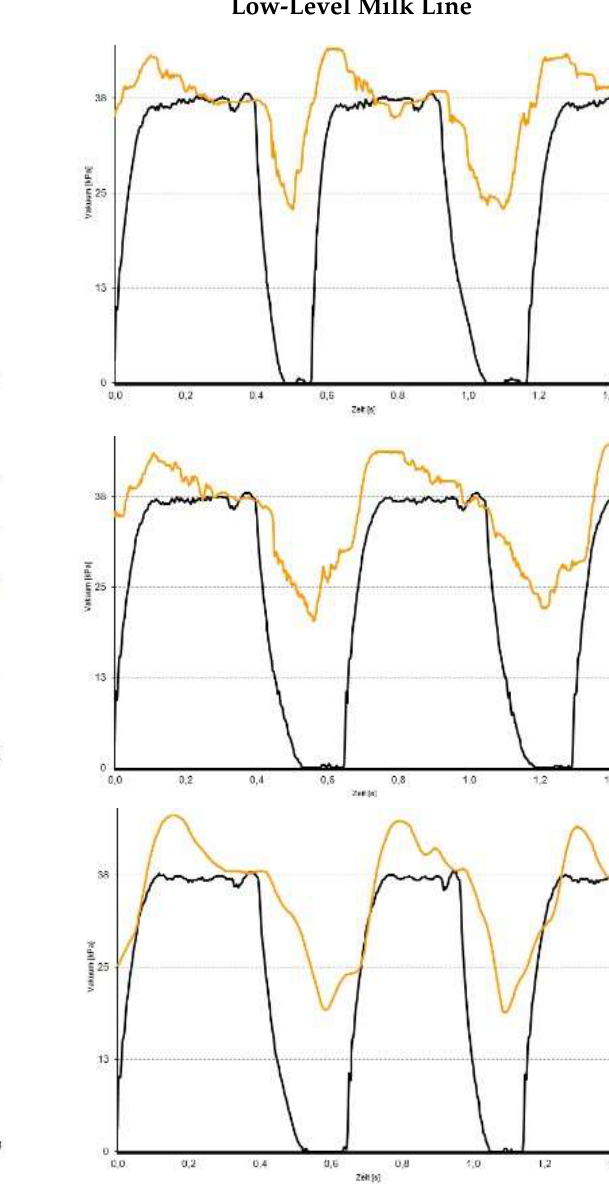
Figure 7. Cyclical vacuum fluctuations in the pulsation and inner chambers of the teat cup during the 1st WF in the goat milking machine, with the following settings: 38 vacuum level (kPa), 90 pulsation rate (cycles/min) and 60:40 pulsation ratio.